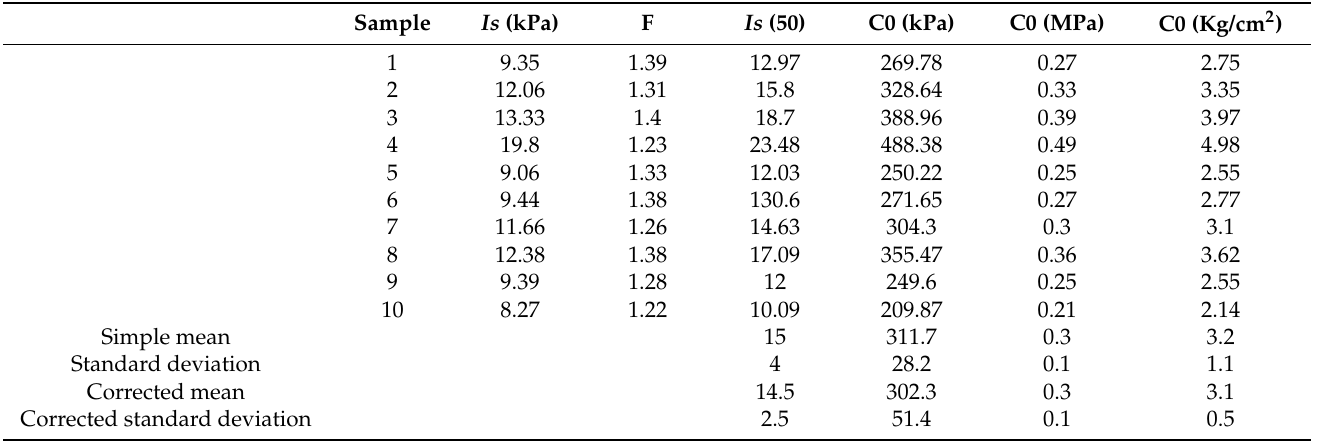
Table A2. Point Load Test